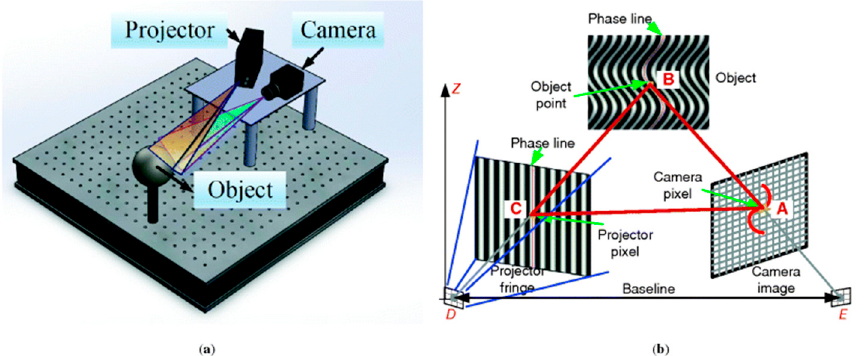
Figure 1. The principle of the fringe projection technique [18]: ( a ) illustration of a fringe projection system with one camera and one projector; and ( b ) schematic diagram of the fringe projection sys- tem.